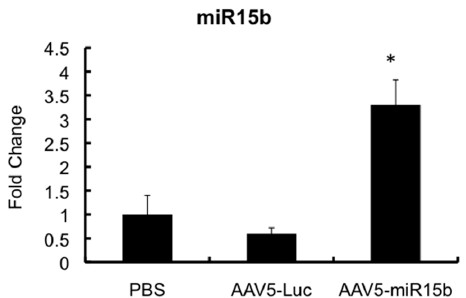
Figure 4. Validation of miR-15b levels in the joints of hemophilia A mice following multiple injuries. Approximately 5 × 10 9 vector particles (in a volume of 10 μ L) of AAV5-miR-15b was injected into the left knee of 10-week-old mice, seven days before the first injury (Day 0). After two injuries, joint specific RNA was isolated and miR-15b levels were determined by qPCR. SNORD68 was used as the housekeeping gene for normalization. * p < 0.05 when compared to the control joints administered with PBS or AAV-Luc vectors.